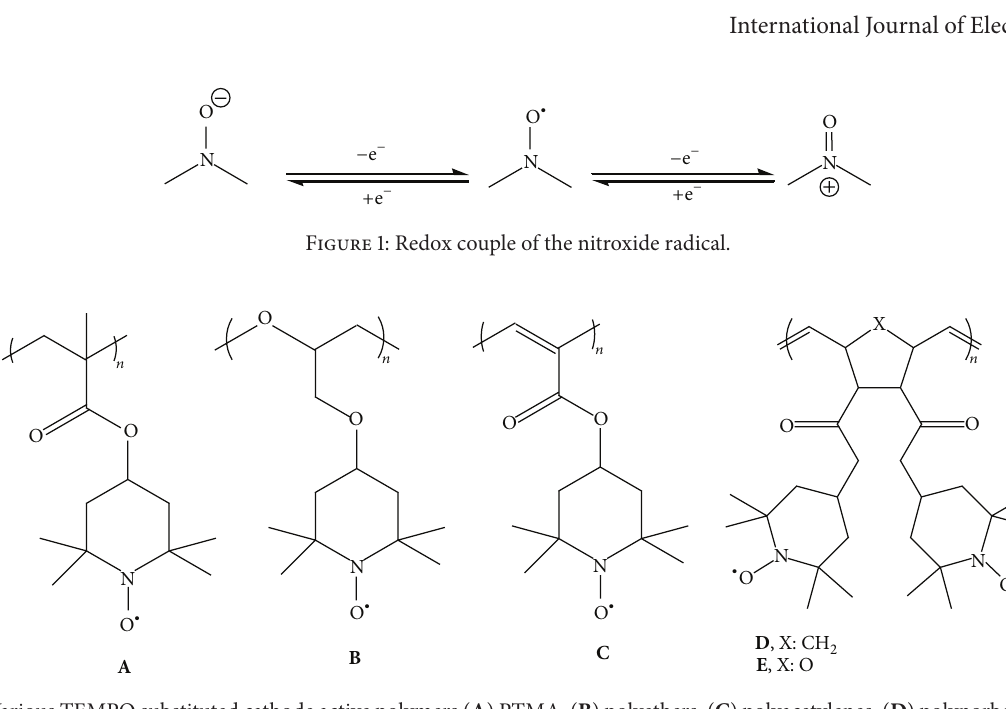
Figure 2: Various TEMPO substituted cathode active polymers ( A ) PTMA, ( B ) polyethers, ( C ) polyacetylenes, ( D ) polynorbornene, and ( E ) poly(7-oxanorbornene).